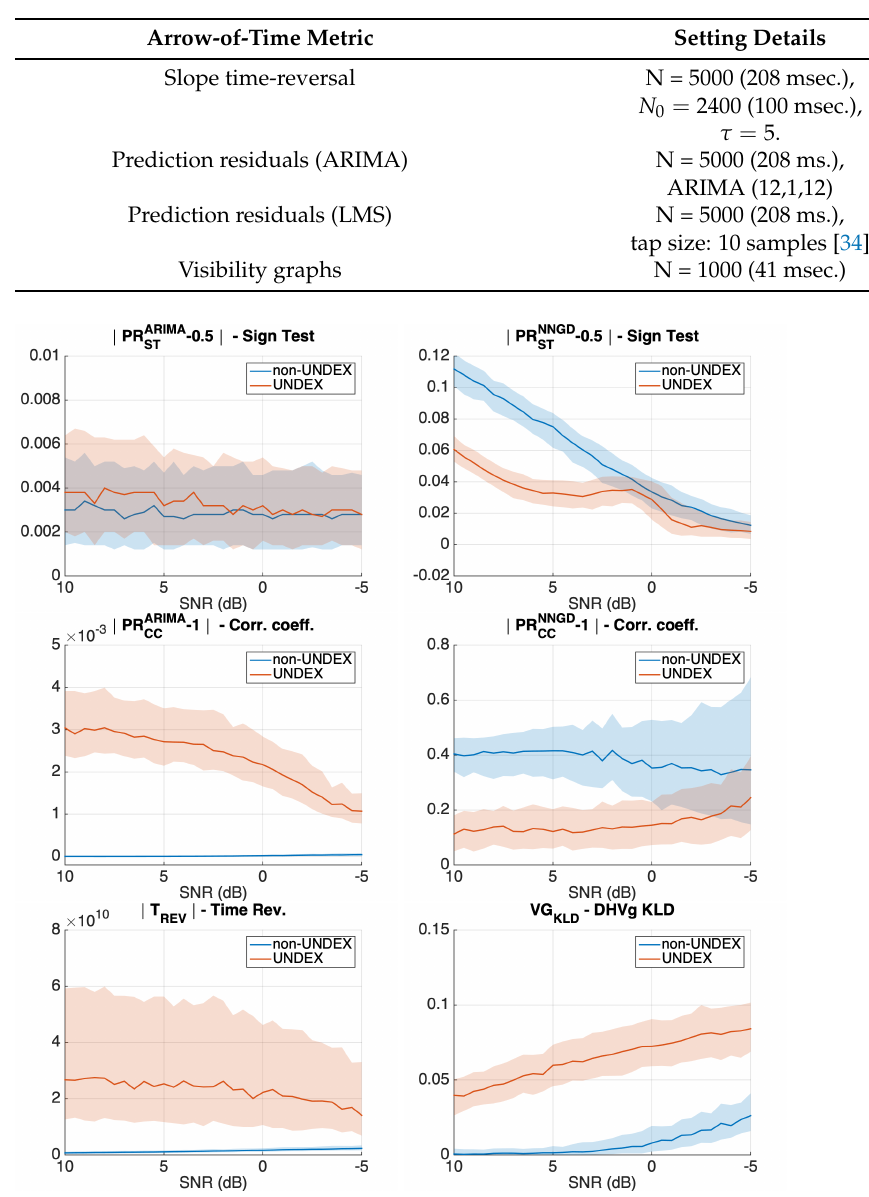
Figure 5. Evolution of all the presented metrics in simulated events when the SNR decreases (Y axis in arbitrary units). The results were obtained for 500 Monte Carlo runs and for unclipped acoustic